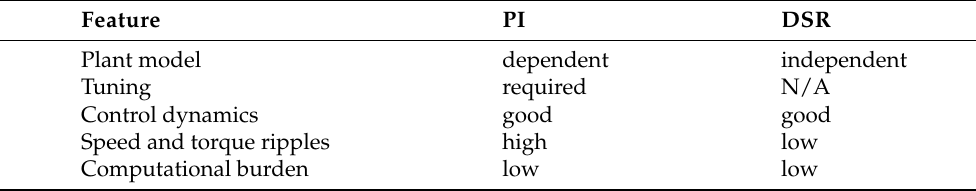
Figure 9. Load variation and sampling rate effect on closed − loop control. Table 3. Comparison analysis of linear and data-driven control